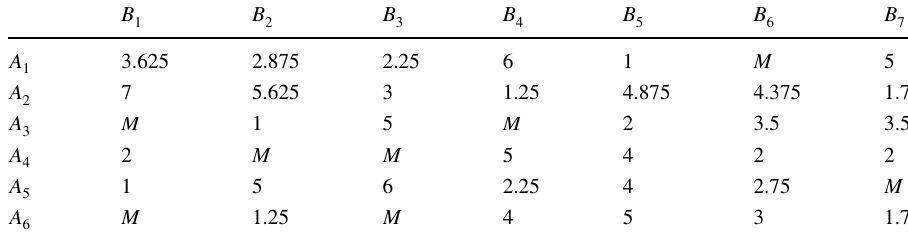
Table 3 Expectation ordinal